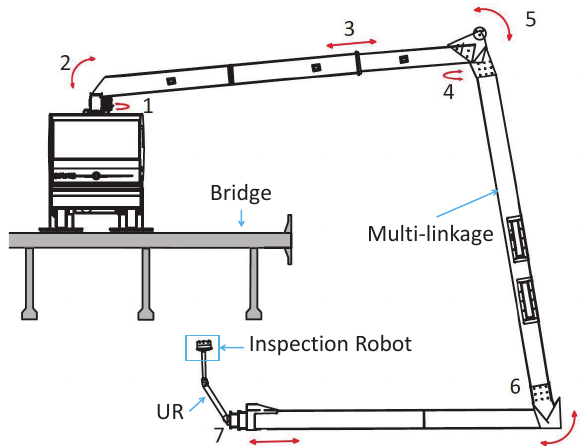
Figure 1: Overview of the total mechanism for our developed bridge inspection system. The arcs with double arrows mean rotation operation and the lines with double arrows mean elongation and shortening of each joint of the multi-linkage arm.